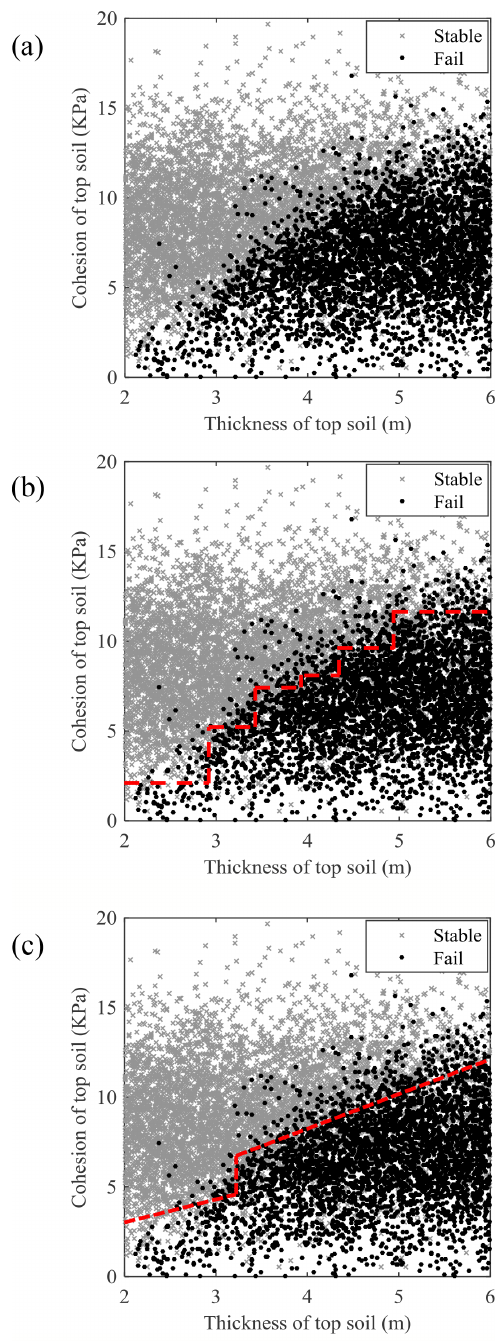
Figure 6. (a) Sampled values of effective cohesion of topsoil versus thickness of topsoil. Black points correspond to simulations result- ing in slope failure, while grey crosses correspond to simulations resulting in a stable slope. (b) As panel a, with the additional red dashed line representing the thresholds derived from the classifica- tion tree in Fig. 5. (c) As panel a, with the additional red dashed line representing the thresholds derived from the classification tree in Fig.